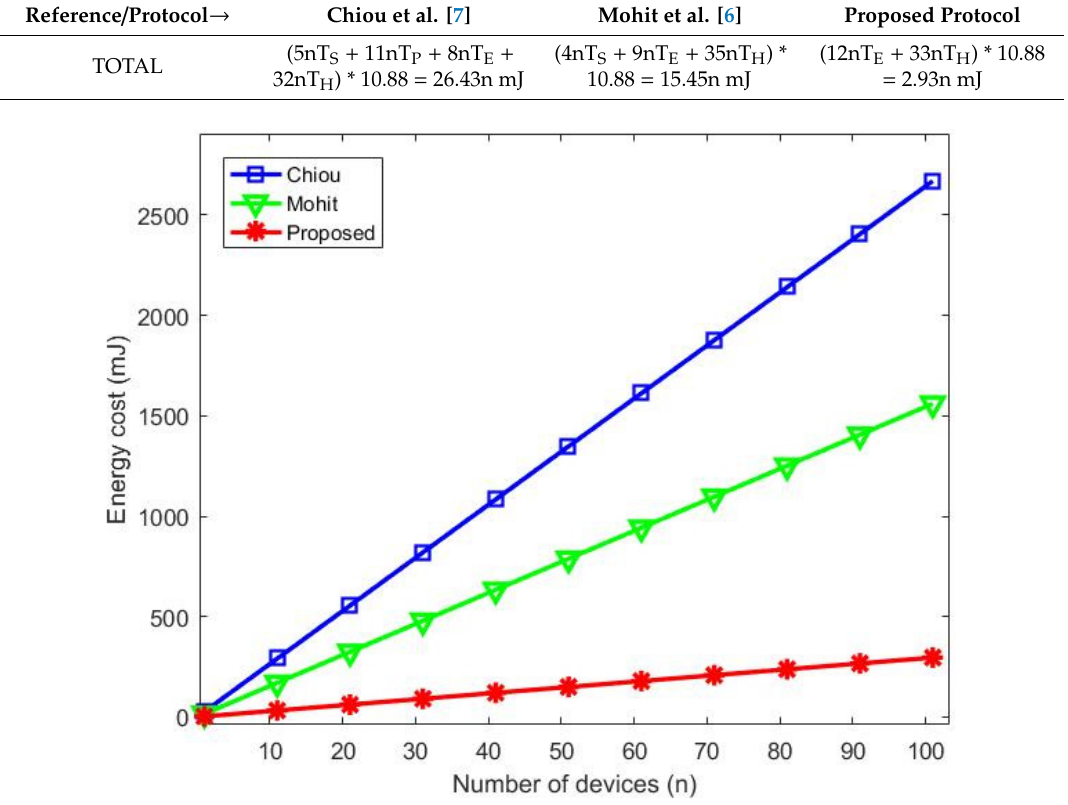
Table 8. Energy cost of protocols.